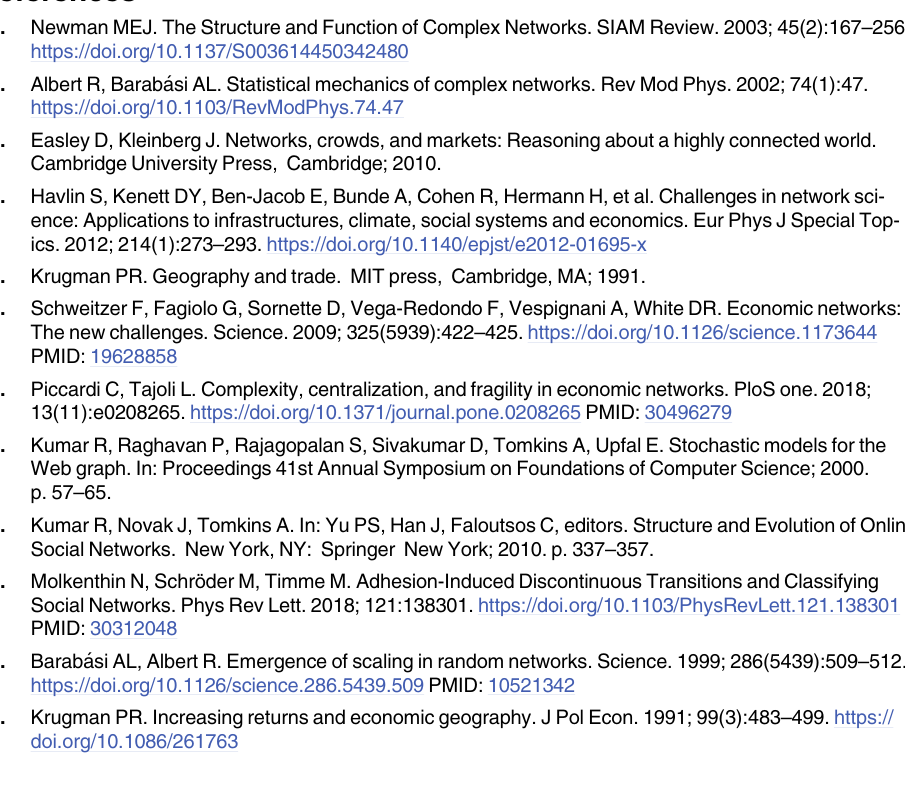
S2 Table. Simulation results. Legends can be found in te readme.txt